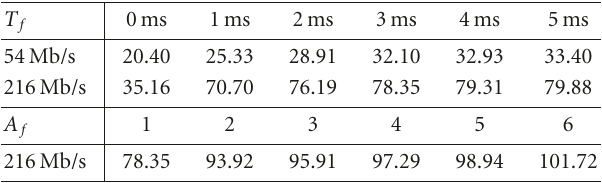
Table 7: Network throughput (Mbits/s) versus T f and A f